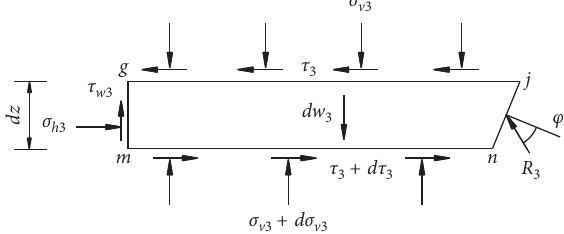
Figure 6: Forces acting on horizontal elements of zone horizontal element; τ is the horizontal shear stress on the 3 surface of the horizontal element, assuming it is an average distribution; the average shear stress coefficient in the height